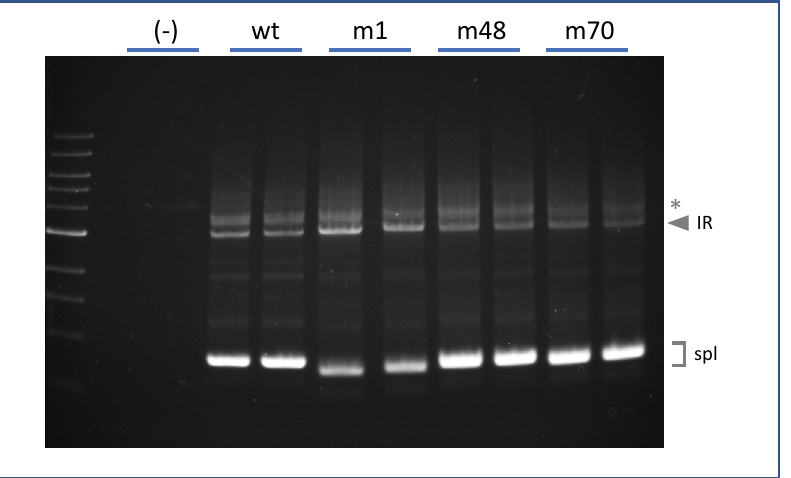
Figure 5. Position-dependence of IR stimulation by cryptic 5 (cid:48) splice sites in E44. Analysis of splicing phenotype for E44 variants. Lanes (-) represent untransfected K562. Other lanes were transfected with VWFwt, VWFm1, VWFm48, and VWFm70. * Indicates PCR